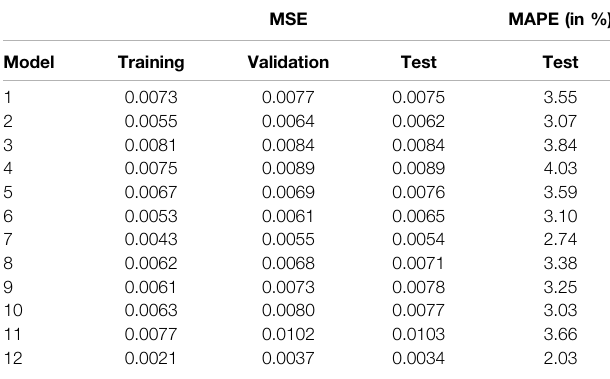
TABLE4| Errormeasuresforthepredictionof M viaANNswhereMSEisgivenfor thetraining, validation and testsets,and MAPEforthetestset.Note thatMSE is evaluated on the logit scale and MAPE on the linear scale.